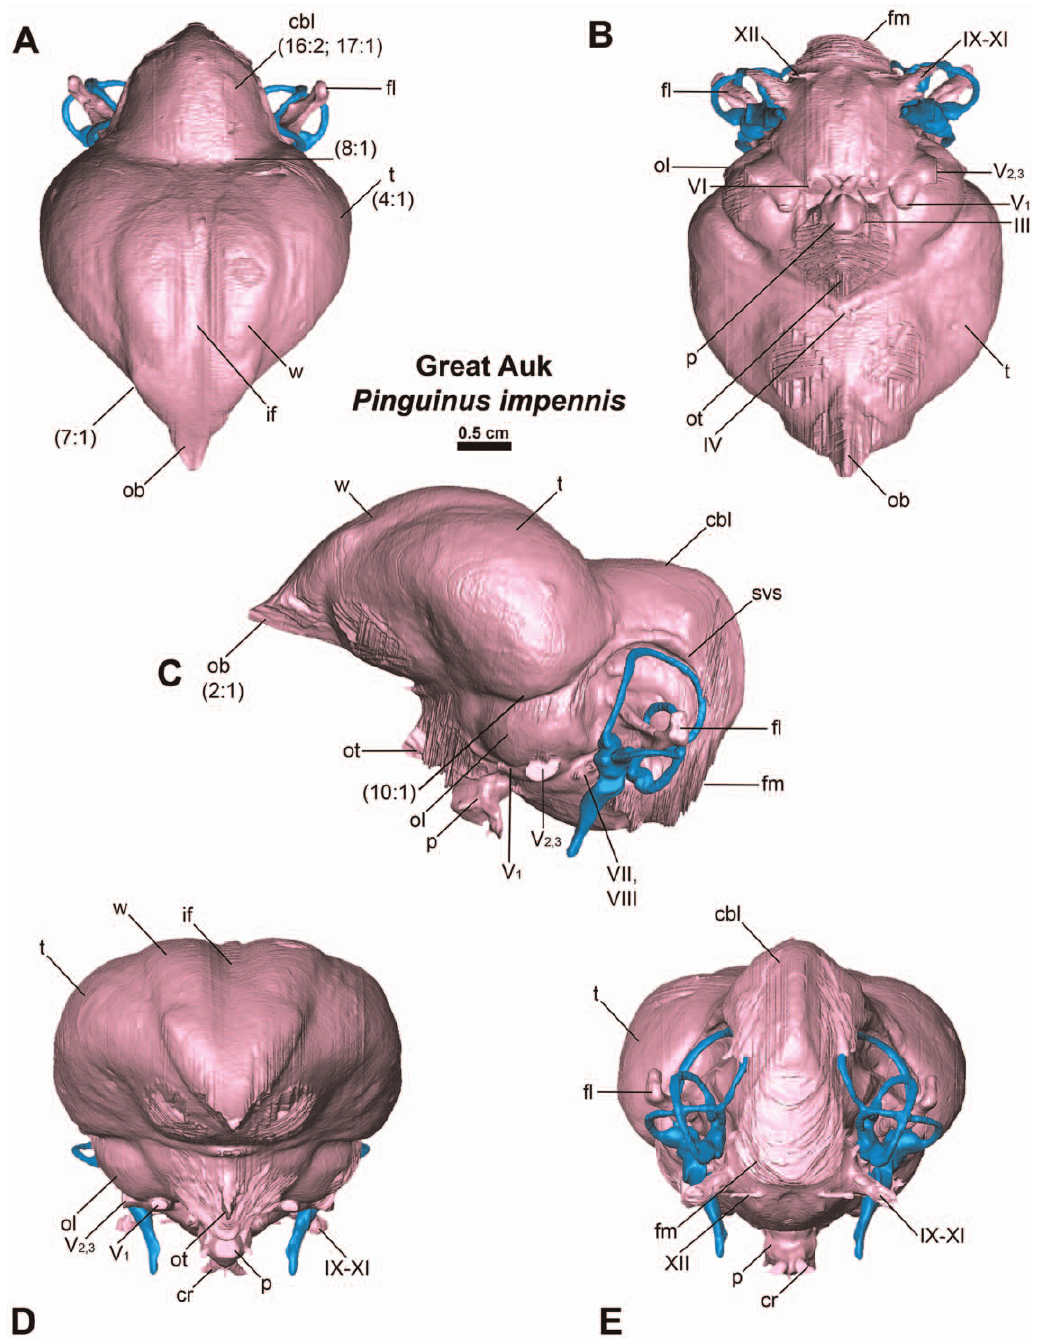
Figure 3. Endocast of the Great Auk Pinguinusimpennis in dorsal (A), ventral (B), lateral (C), anterior (D), and posterior (E) views. Numbers in parentheses represent character states from Appendix S1.